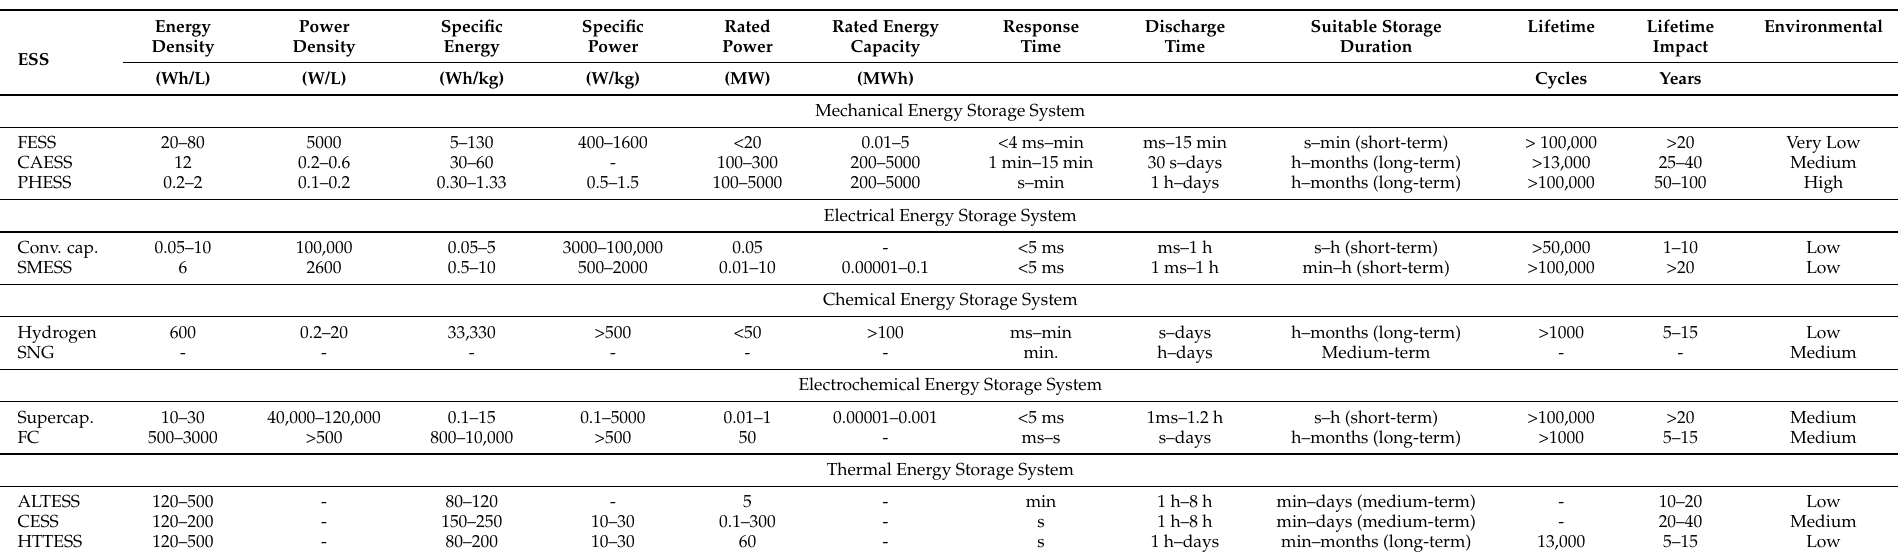
Table 2. Key Technical characteristics of the main